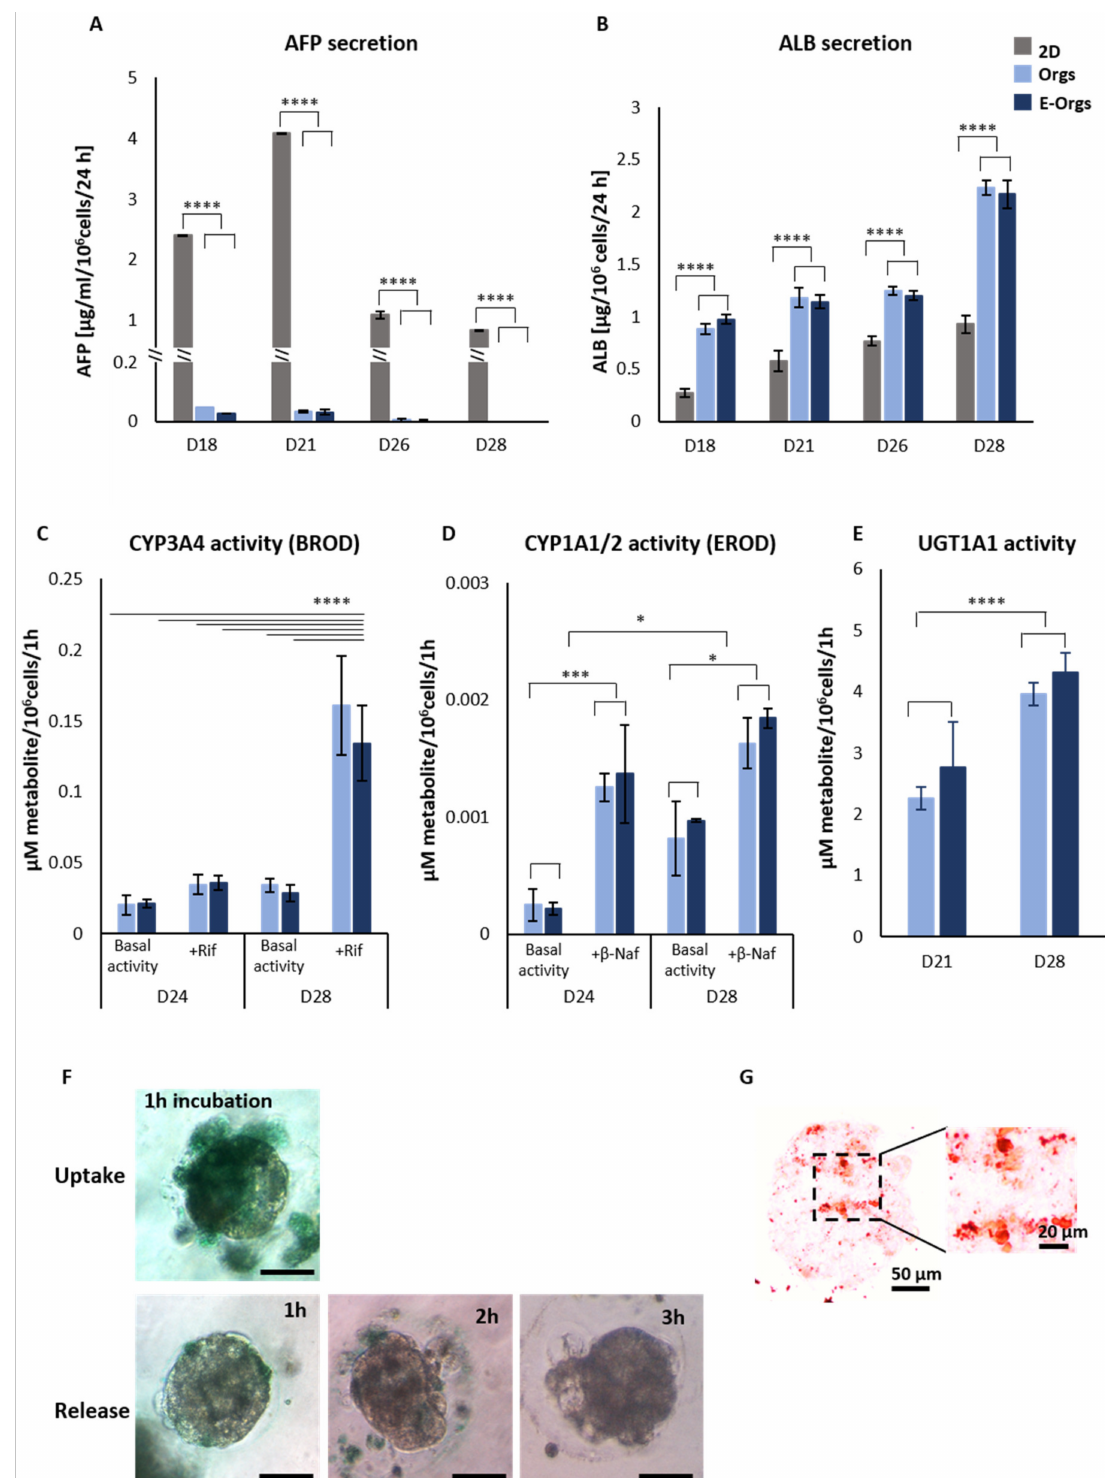
Figure 3. Functional assessment of iHep-Orgs and E-iHep-Orgs. ( A , B ) Plasma protein AFP and ALB secretion by iHeps at the indicated time points are shown. Histograms represent mean ± SD ( n > 10). ( C – E ) Xenobiotic metabolism Phases I and II. CYP3A4 activity determined by BROD, histograms represent mean ± SD ( n = 5); CYP1A1/2 activity determined by the EROD test. The histograms represent mean ± SD ( n = 4). UGT1A1 activity; the histograms represent mean ± SD ( n = 8). ( F ) Indocynanine green uptake and release assay in E-iHep-Orgs (scale bar: 100 µ m). ( G ) Oil Red O staining of lipid droplets in E-iHep-Orgs. p < 0.0001 (****), p < 0.001 (***), and p < 0.05